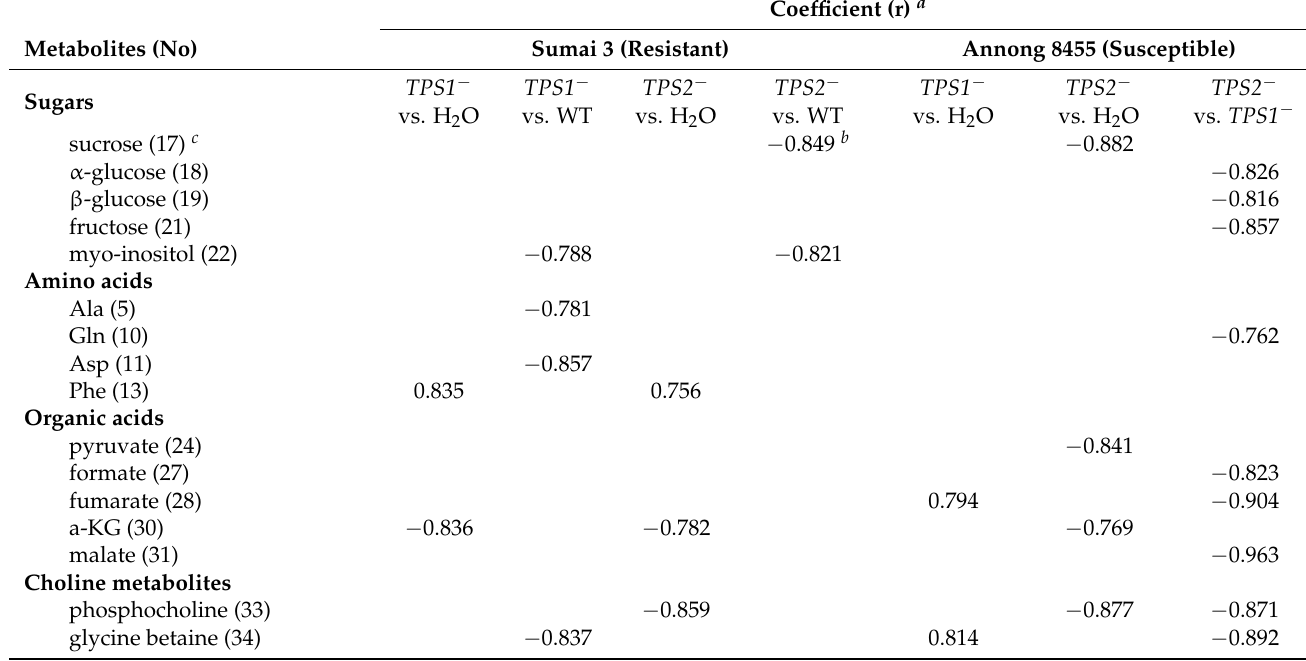
Table 1. Significantly changed metabolites in the resistant and susceptible wheat when inoculated with ddH 2 O (H 2 O), WT, TPS1 − , and TPS2 −